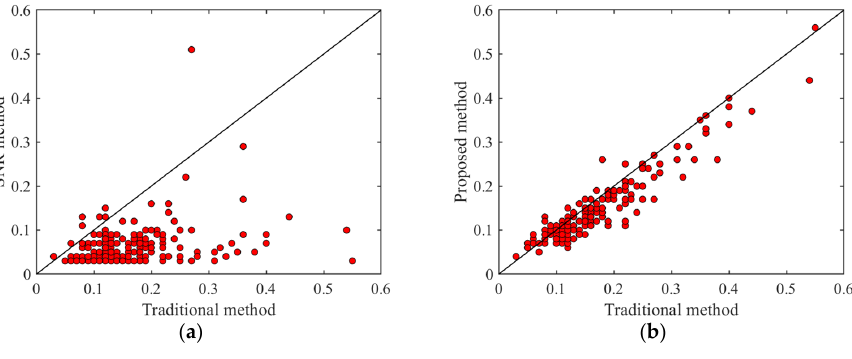
Figure 14. The obtained high ‐ pass cut ‐ off frequency (unit: Hz). (a) SNR method (b) Proposed Figure 14. The high-pass cut-off frequency obtained via SNR method and proposed method (unit: method. Hz). ( b ) Proposed